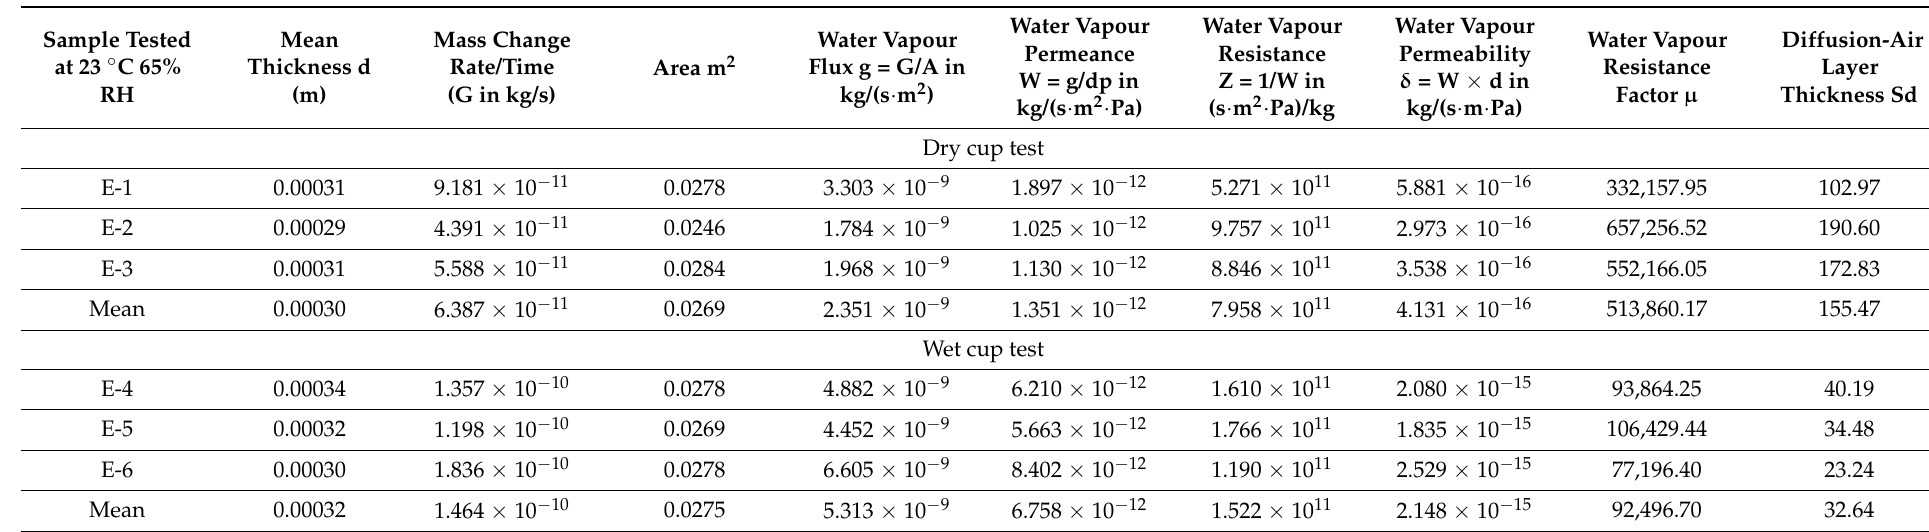
Table A12. Water vapour resistivity properties for sample E at 23 ◦ C 65%